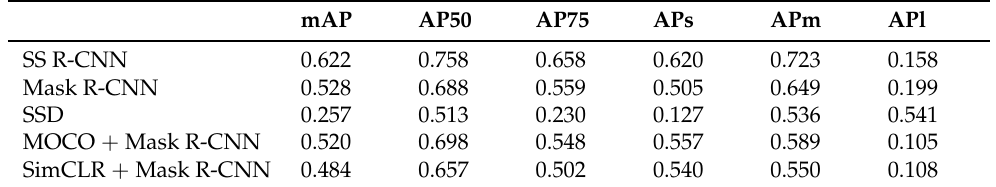
Table 2. Comparison with the baseline methods.